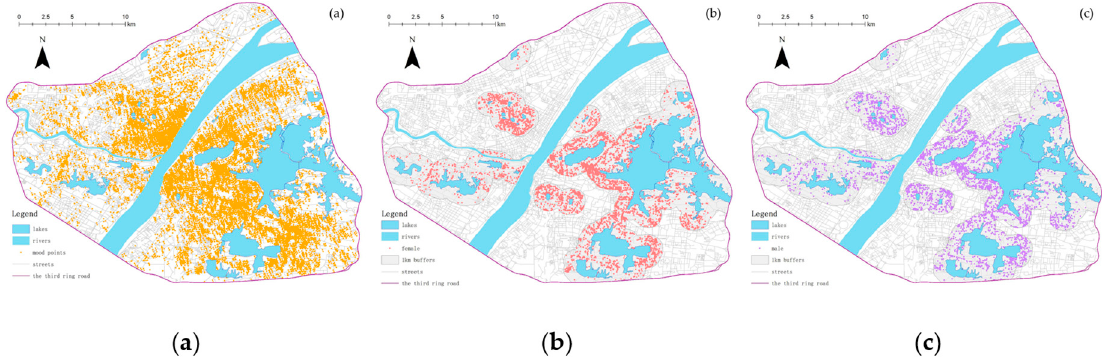
Figure 3. Visualization results of Weibo points. ( a ) the display of all data in the Wuhan Third ring Road, ( b ) Display of female data in the lake bu ff er zone in the Third Ring Road, ( c ) Display of male data in the lake bu ff er zone in the Third Ring